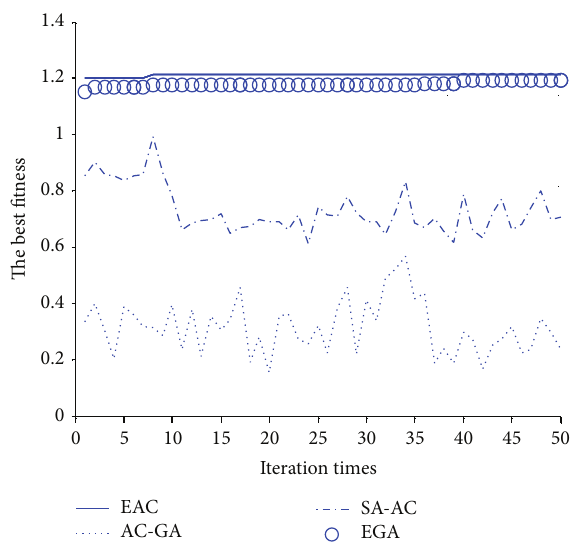
Figure 21: Convergence curves about the optimal fitness on map III.